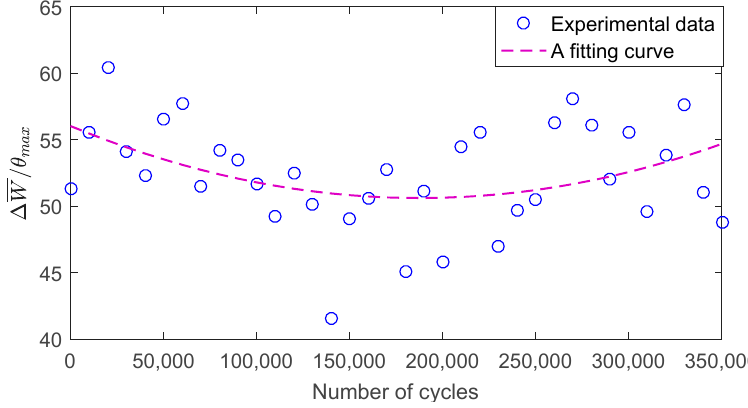
Figure 7. Typical hysteresis loops of the viscoelastic material after cyclic impacts.